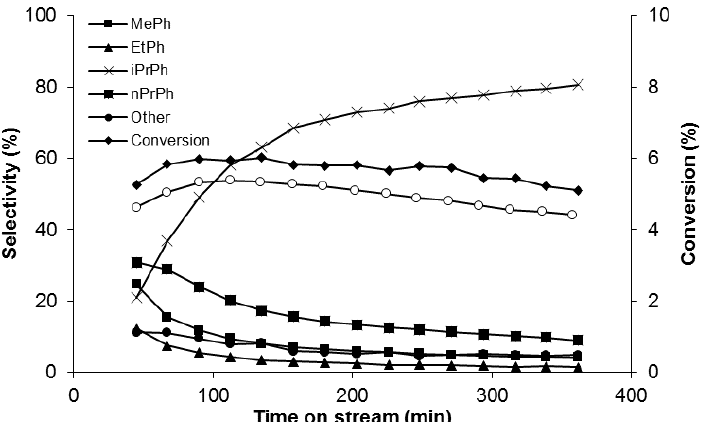
Figure 5. Time course for benzene alkylation by propane over two ‐ bed catalyst 9.9% Au/6.0% Pd/C (0.04 g, top bed) + 25%HSiW/SiO 2 (0.16 g, bottom bed) (0.20 g total catalyst weight, 2% Au, 1.2% Pd, 300 °C, 1 bar pressure, inlet molar ratio C 6 H 6 /C 3 H 8 = 1:9, 10 mL min − 1 flow rate, W / F = 80 g h mol − 1 ; catalyst pre ‐ treatment at 300 °C/1 h in H 2 flow). Open circles show the conversion with Pd/C + 25% HSiW/SiO 2 (1.4% Pd) taken from Figure 4 for comparison.